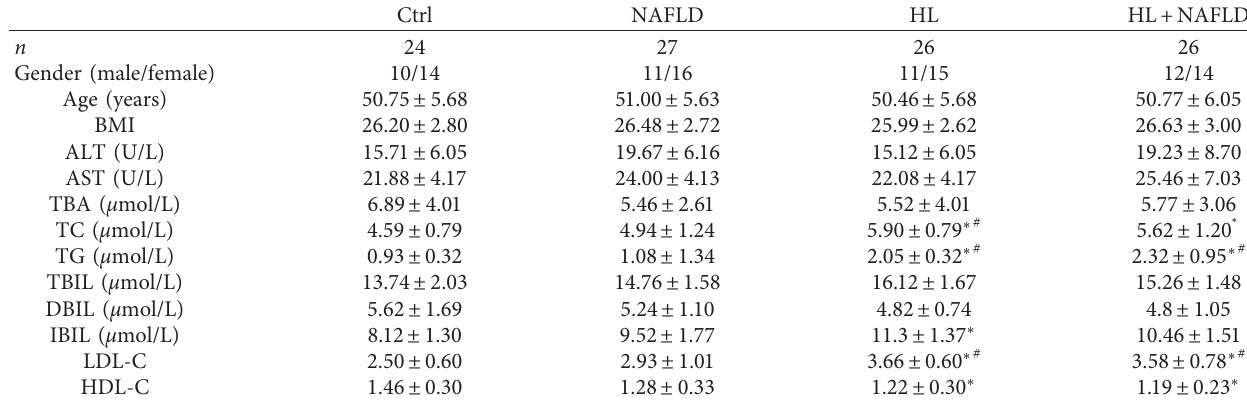
Table 1: Clinical parameters in subjects from four groups.